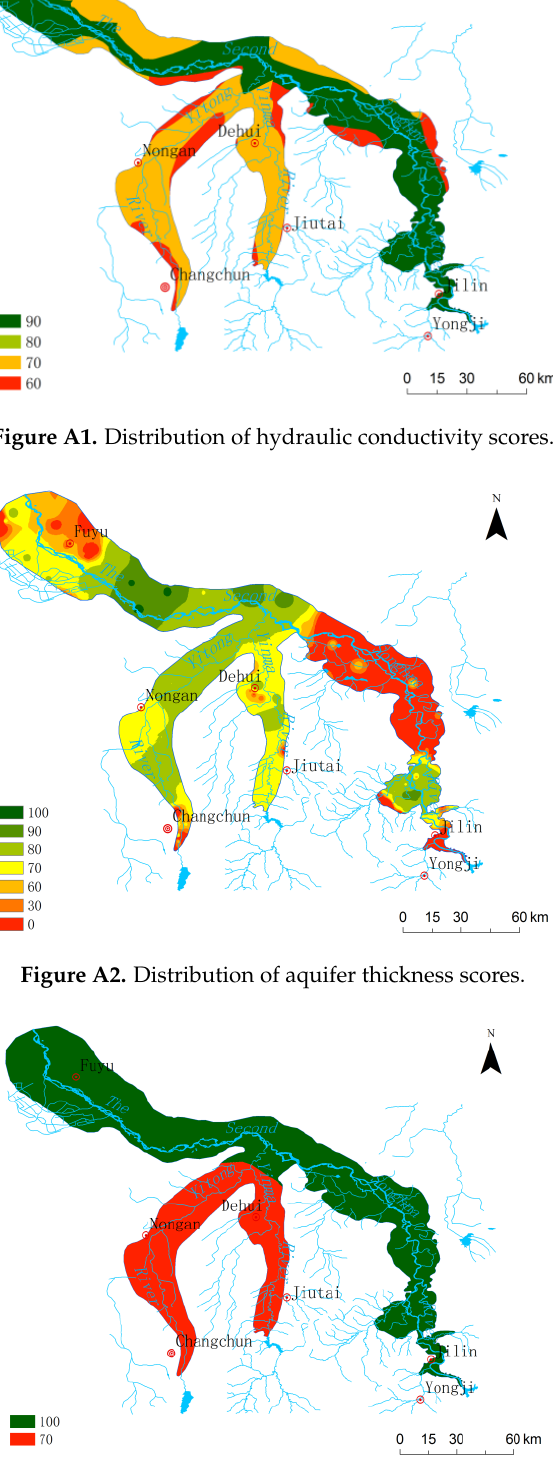
Figure A3. Distribution of annual average runoff scores.